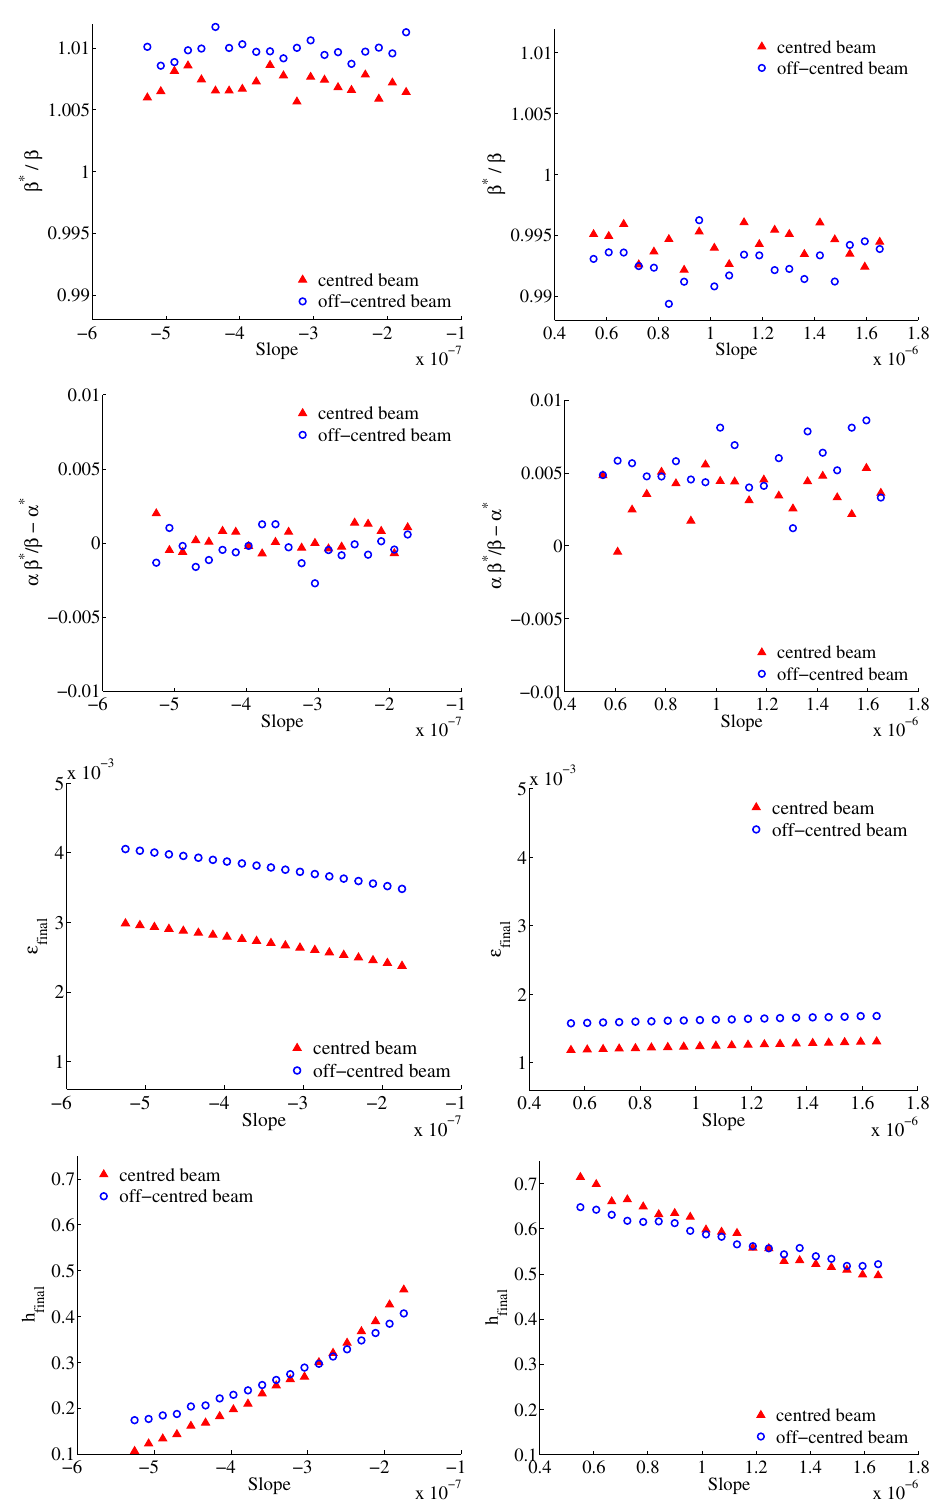
FIG. 8. (Color) Optical mismatch parameters, final emittance, and halo parameter as a function of the slope of the tune curve during the resonance crossing for the four-turn injection (left column) and for the three-turn injection (right column). The solid triangles correspond to injecting the beam at the center of the rightmost island, while the open circles to injecting the beam displaced from the (cid:6) (cid:3) (cid:5) 0 : 255 ; 0 : 251 ; 0 : 248 (cid:6) [respectively ; (cid:3) ; (cid:3) island’s center. For the four-turn injection (respectively three-turn) the tune values are (cid:5) (cid:3) a b c (cid:5) 0 : 328 ; 0 : 341 ; 0 : 35 (cid:6) ], the constant value of (cid:8) is 0 : 014 (respectively 0.017), and the displacement of the off-centered beam is (cid:1) ^ X (cid:3) initial 0 : 0176 (respectively 0 : 0192 ). In both cases, the number of initial conditions for each injected turn is 10 6